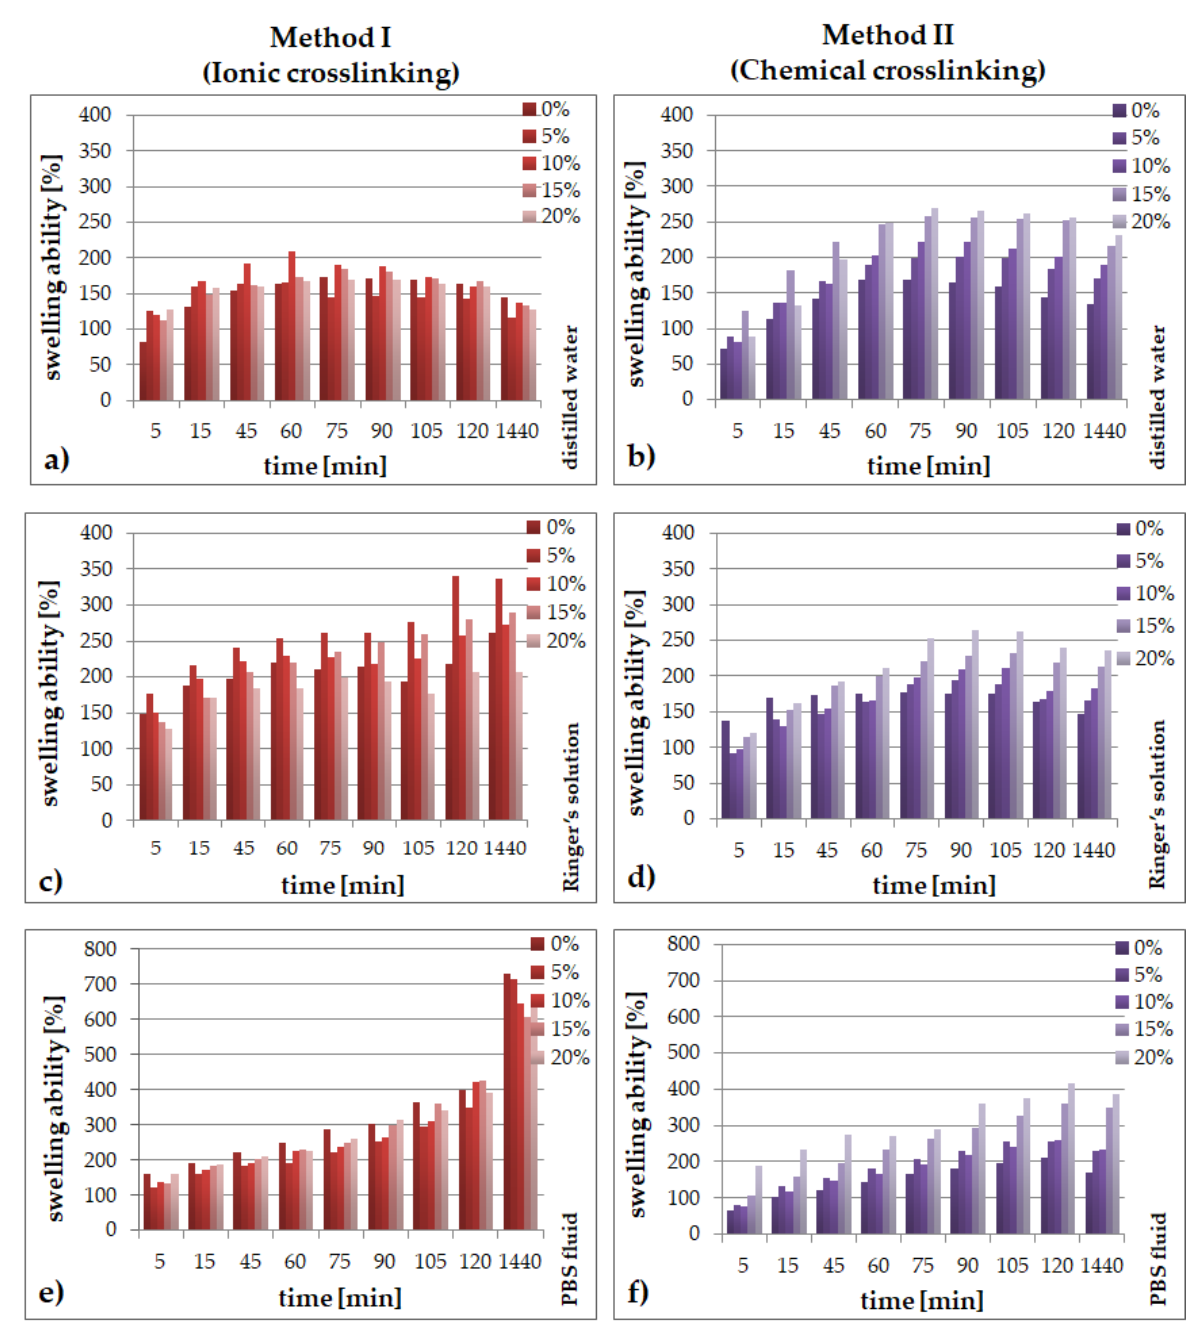
Figure 1. Swelling ability for SA/PVA/ EP hydrogels obtained using method I (left side) or method II (right side) in: ( a , b ) distilled water; ( c , d ) Ringer’s solution; ( e , f ) in PBS fluid.